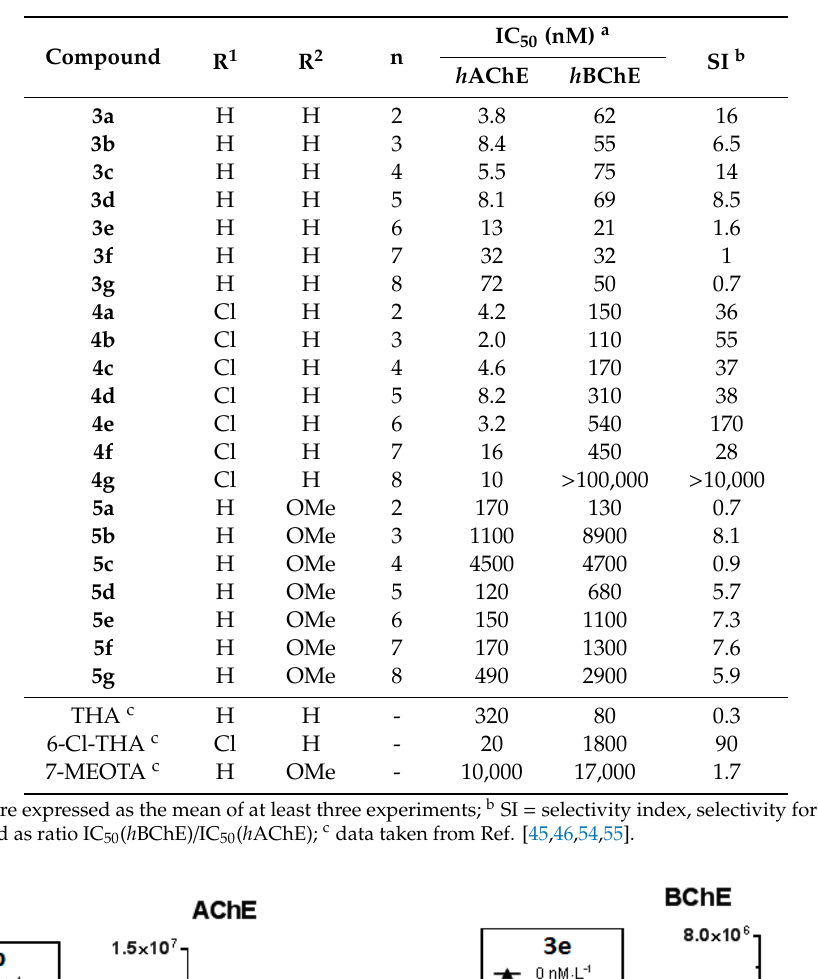
Table 1. h AChE and h BChE inhibitory activities of tacrine-squaramide homodimers and reference compounds THA, 6-Cl-THA and 7-MEOTA.